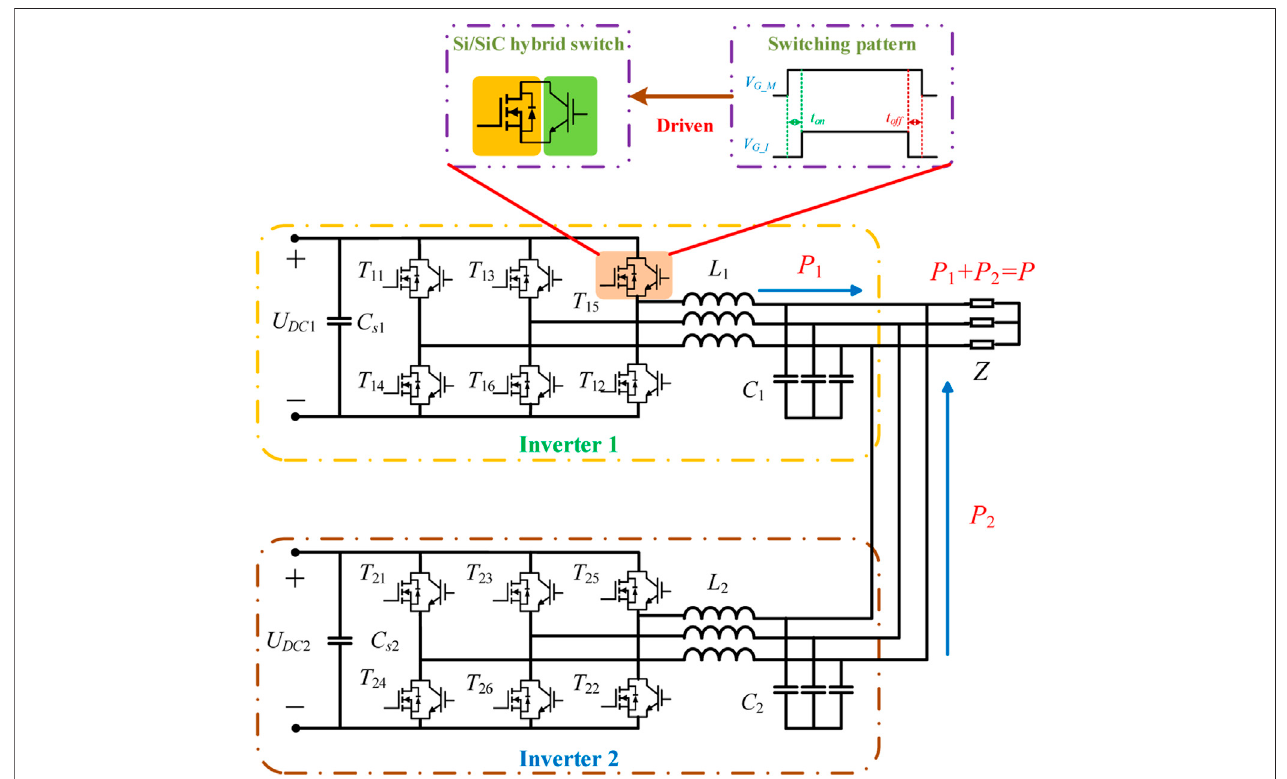
FIGURE 1 | Structure of Si/SiC hybrid switch based modular inverter system.